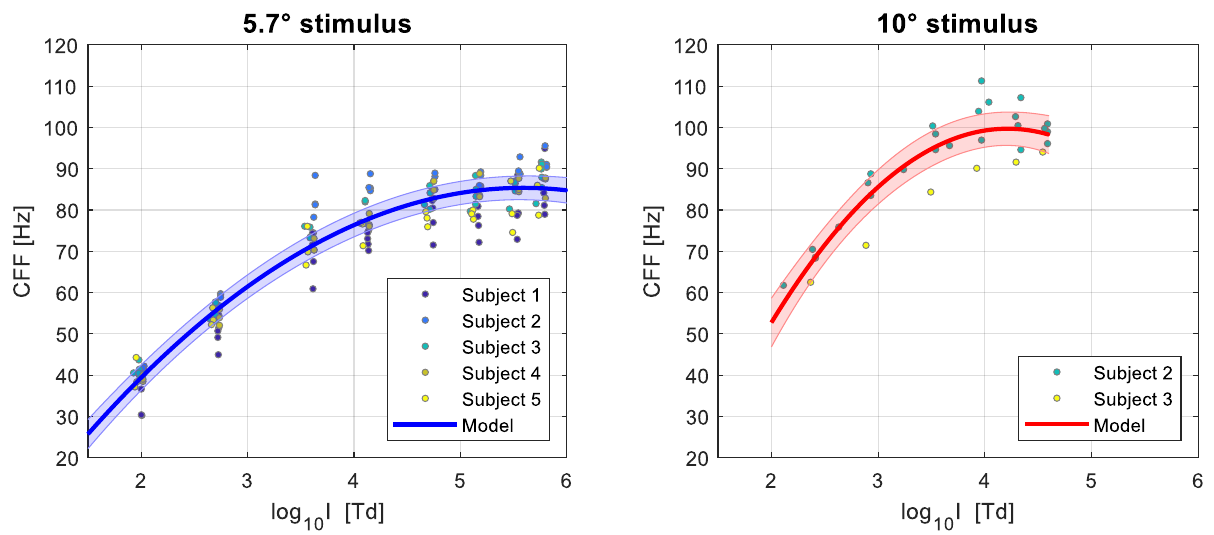
Figure 5. Quadratic linear mixed model results of CFF as a function of log 10 retinal illuminance, for stimulus sizes of 5.7 ( left ) and 10 ( right ) degrees of visual angle. The continuous colored lines represent the model fit and the shaded regions represent the 95% confidence intervals. The individual markers show the estimated thresholds for each subject over several experimental sessions, and the color of the markers represents the participant as indicated by the legend.